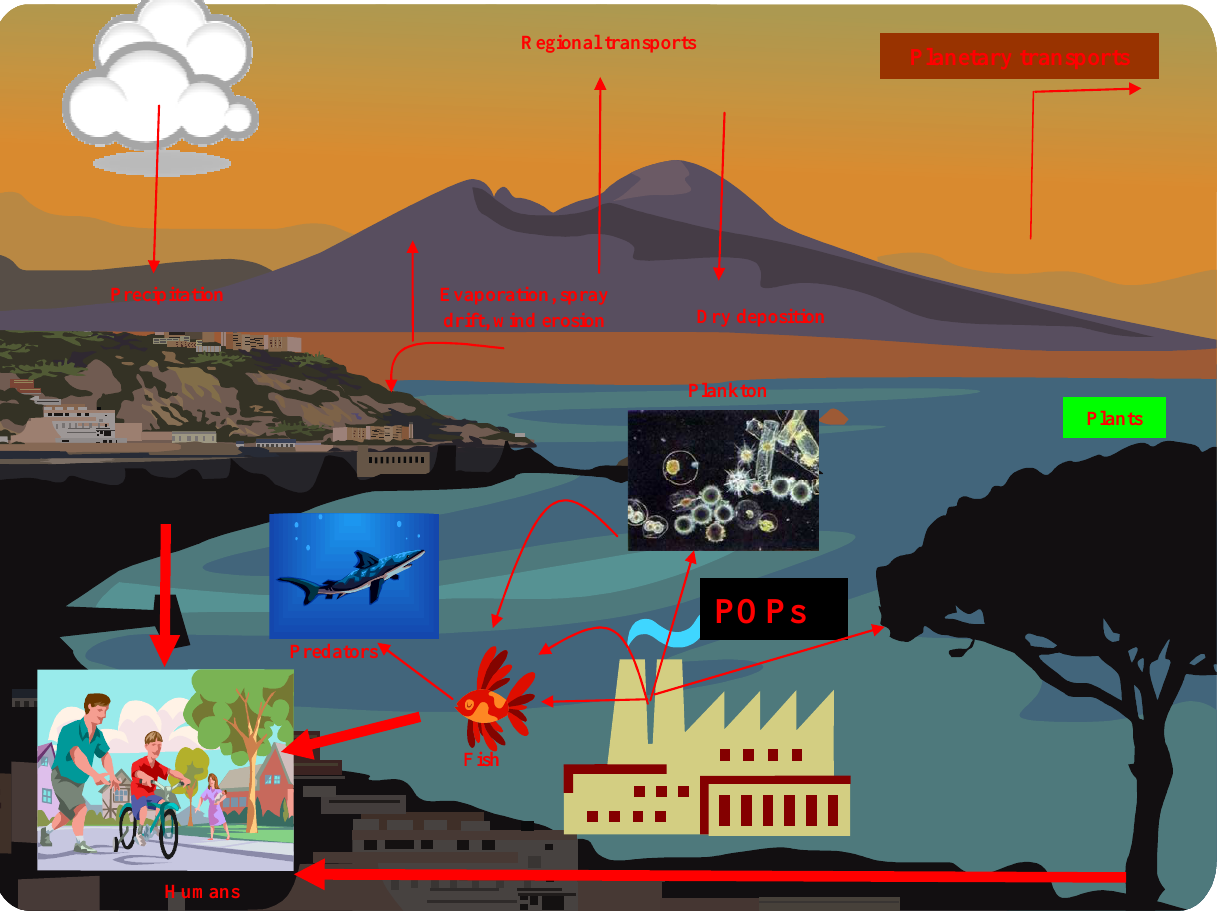
Figure 8. Schematic of the POP cycle in the environment. POPs are released from local sources and transported via atmosphere. They enter locally into water ecosystems (particularly plankton); plankton is subsequently consumed by fish. Predators including humans are also affected because they stand in the top of food chain. The second way is surface contamination of